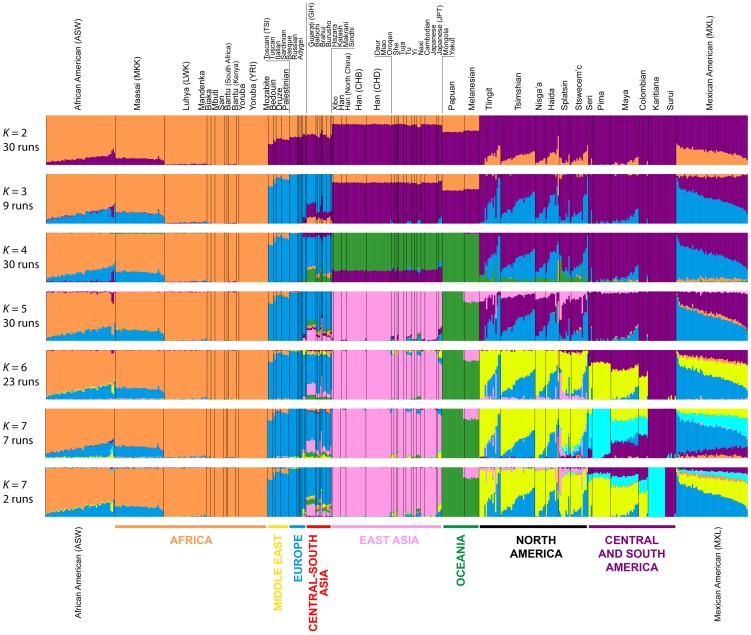
Worldwide Admixture structure.Plotted are modes with clustering solutions obtained with 30 replicates at each value of K. Values of K and the number of runs in the mode shown appear on the left. In each plot, each cluster is represented by a different color, and each individual is represented by a vertical line divided into K colored segments with heights proportional to genotype memberships in the clusters. Thin black lines separate individuals from different populations. The same 528 individuals included in Figure 4B are considered in the Admixture analyses. Alternate clustering solutions for values of K from 2 to 12 appear in Figure S3.